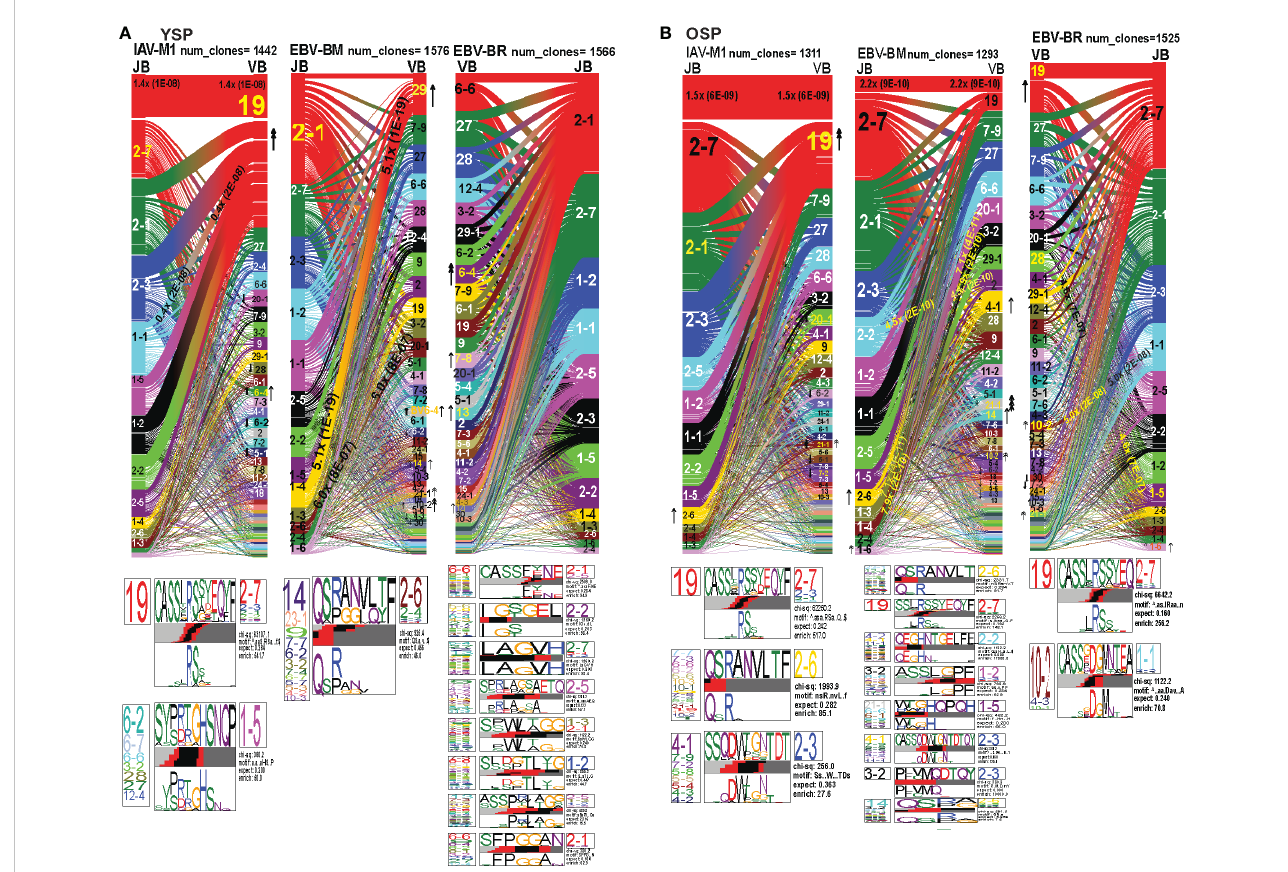
FIGURE 7 TRBV and TRBJ gene pairing and CDR3 motifs for IAV-M1, EBV-BM and EBV-BR CD8 T cell populations differ between young and older. This was determined after TCR high throughput sequencing of tetramer-sorted CD8 T cells in Y and O donors (Y, n=4; O, n=4-5) using ribbon-plot analyses. Ribbon plots show patterns of TCR V-J pairings in TRBV in young (A, B) older donors (num_clones, indicates the number of clones analyzed). Genes are colored by frequency within the repertoire with red>green>blue>cyan>magenta>black. The arrows indicate fold increase usage of those V or J regions compared to naïve random repertoire suggesting antigen-driven expansion (no. of arrow heads are log 2 ). Underneath each ribbon plot are the unique clearly de fi ned CDR3 motifs of TRBV repertoire of the indicated antigen-speci fi city. There can be multiple different CDR3 motifs for any one speci fi city. For each CDR3 motif, the upper motif 1 (labeled Mf1 in young IAV-M1 as a representative) shows the amino acids which are enriched in comparison to the total tetramer+ population of that speci fi city; the lower motif 2 (labeled Mf2 in young IAV-M1 as a representative) shows the amino acids which are enriched compared to a naïve random CD8 T cell repertoire. Both indicate that the identi fi ed amino acids are important for an antigen peptide/MHC contact. Naive repertoires do not generate motifs as this requires the presence of clonal expansions. (analysis method from Dash et al. (6); Kamga et al. (8). The text within the bars joining particular BV and BJ gene regions indicate the fold increased usage of that pairing (and statistical signi fi cance) compared to a naïve random TCR repertoire. Bar in between the Mf1 and Mf2 depicts which part of the CDR3 is derived from the V (light grey), N (red), D (black) and J (dark gray)